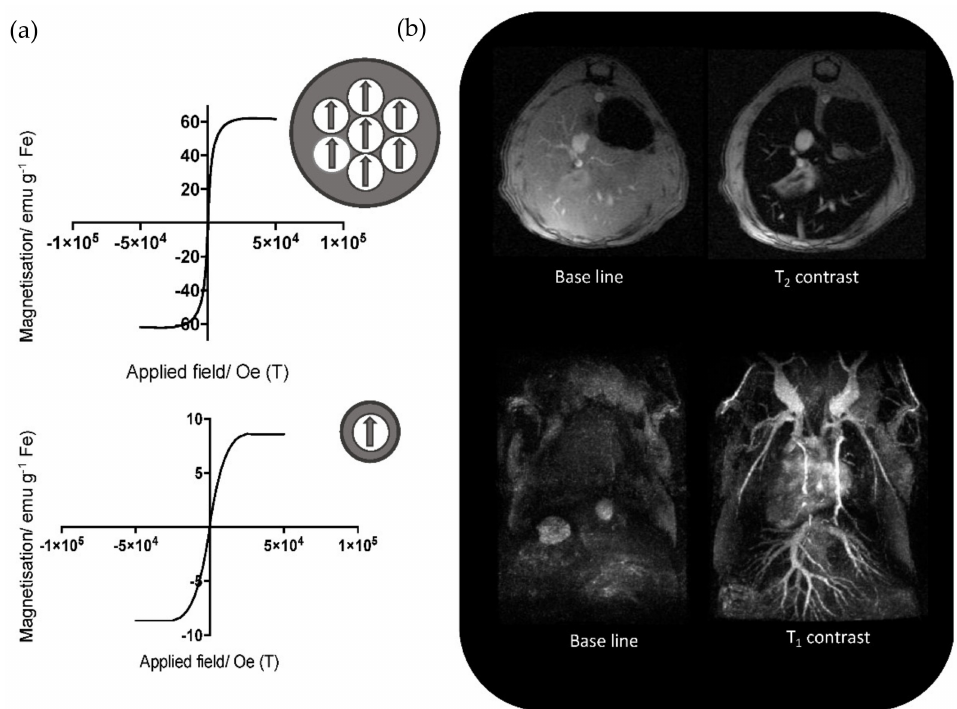
Figure 2. ( a ) Magnetic moment per gram of iron of larger (top) and smaller (bottom) IO-MNPs (note the change of scale). ( b ) Mouse liver T2-MRI using larger IO-MNPs (top) and T1-MRI angiography using smaller IO-MNPs. Reproduced with permission from MDPI